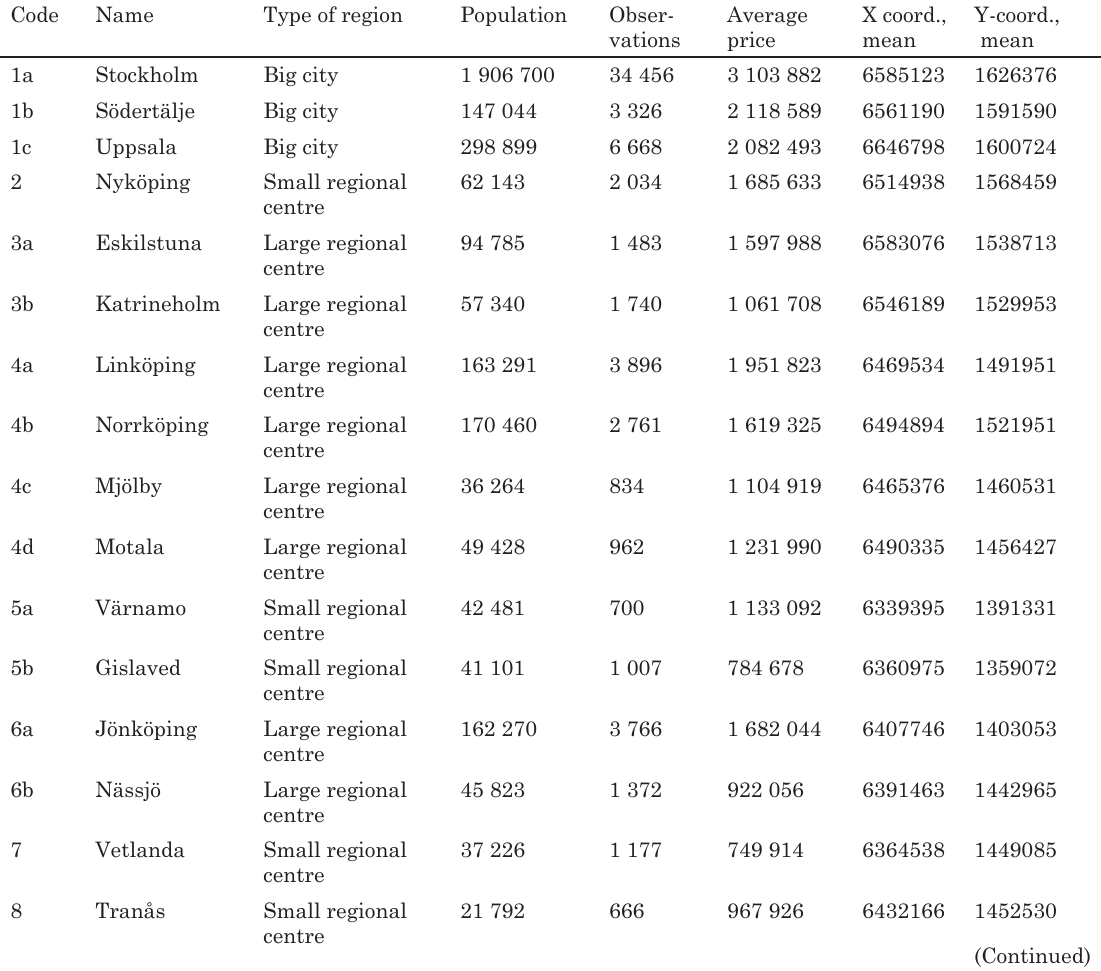
Table 2. Descriptive statistics for each region